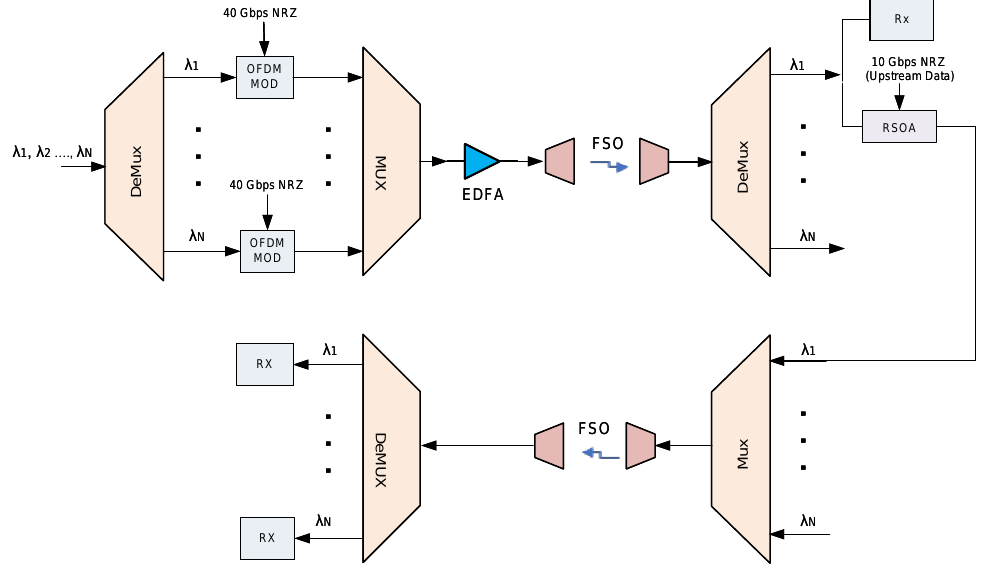
Figure 2. The bidirectional WDM FSO